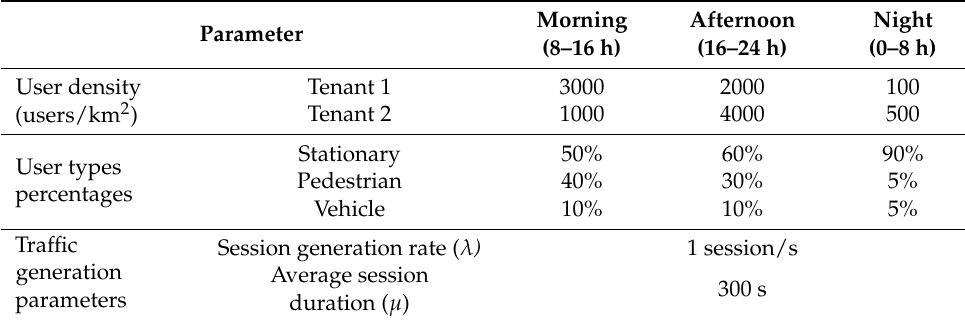
Table 2. Emulation parameters for